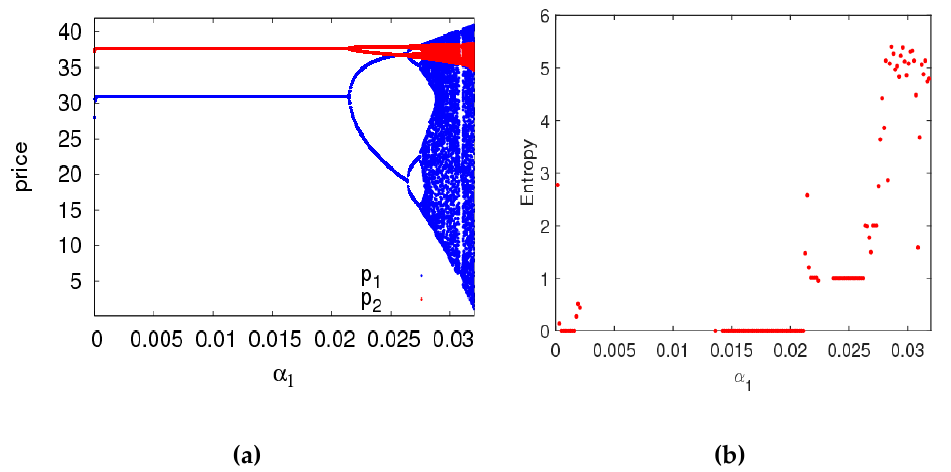
Figure 20. Bifurcation diagram and entropy of control system (12) with respect to α 1 when v = 0.5. ( a ) The bifurcation diagram, ( b ) The entropy diagram.